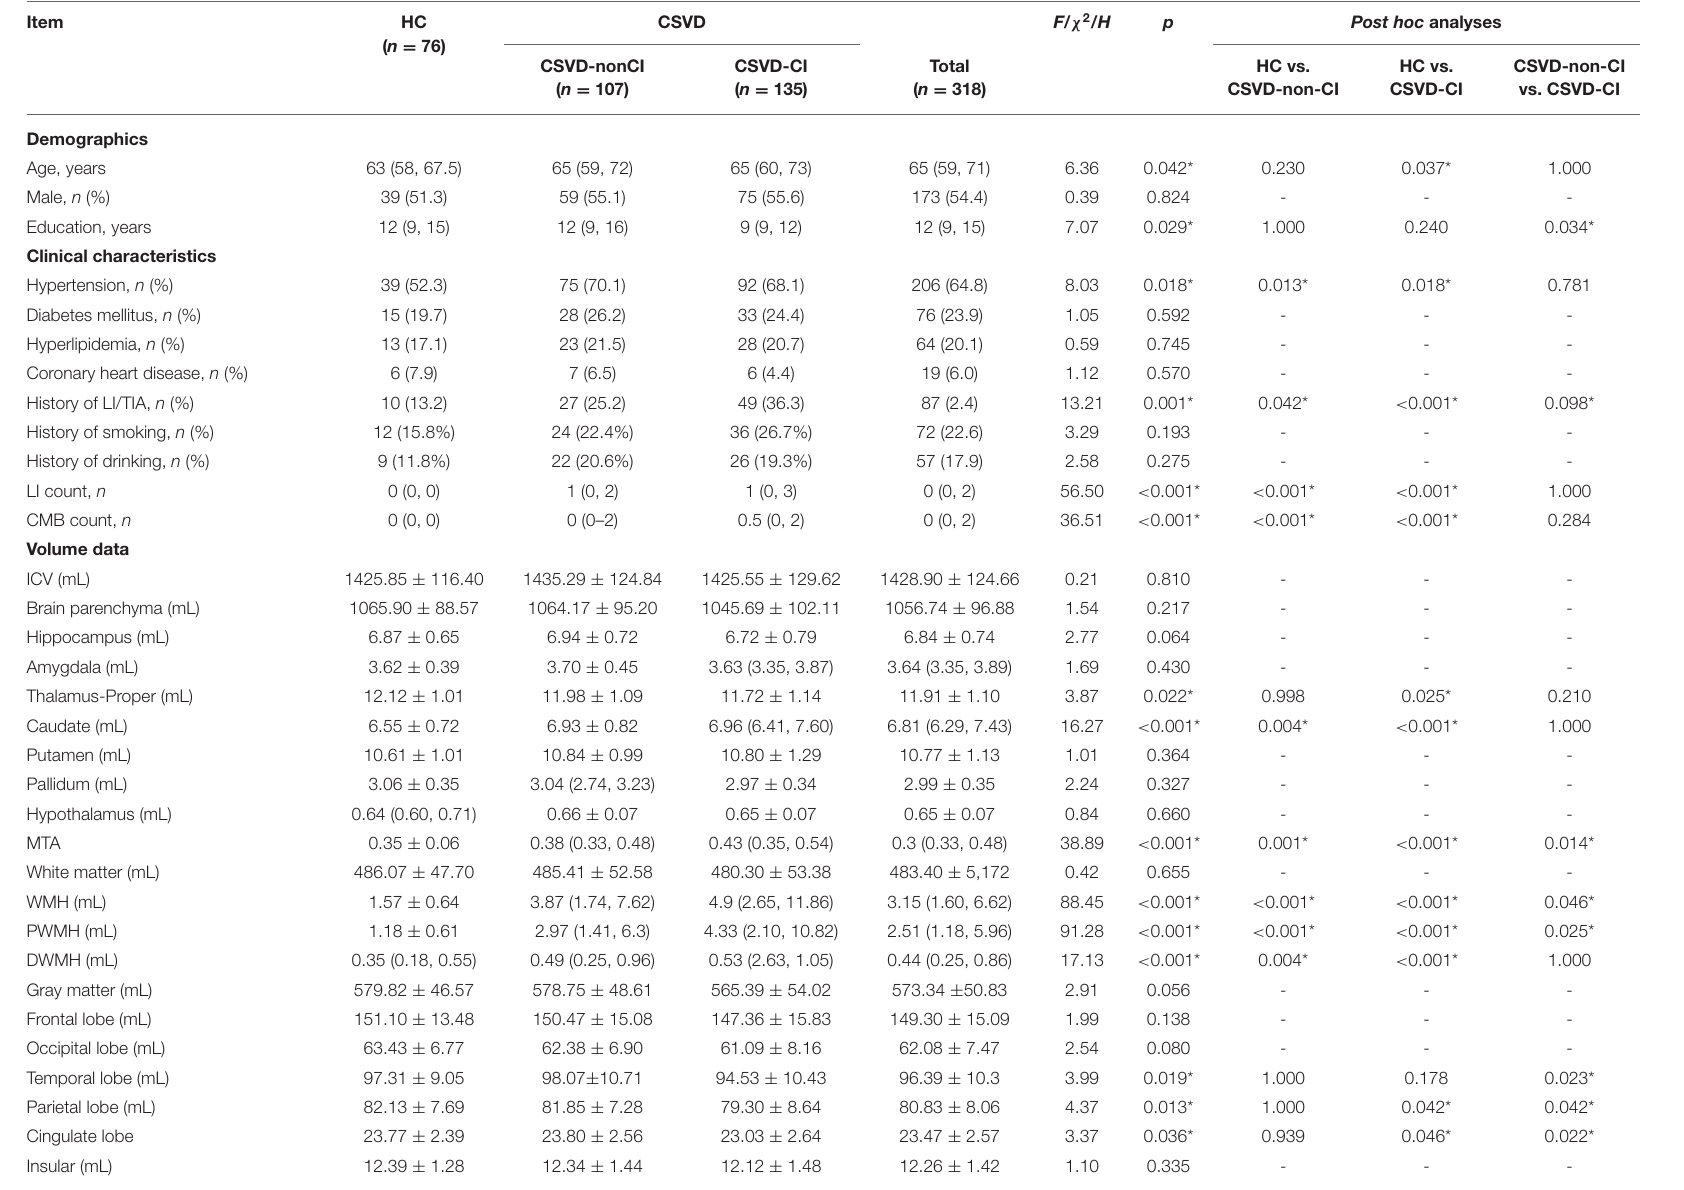
TABLE 1 | Demographic, clinical, volume, and neuropsychological